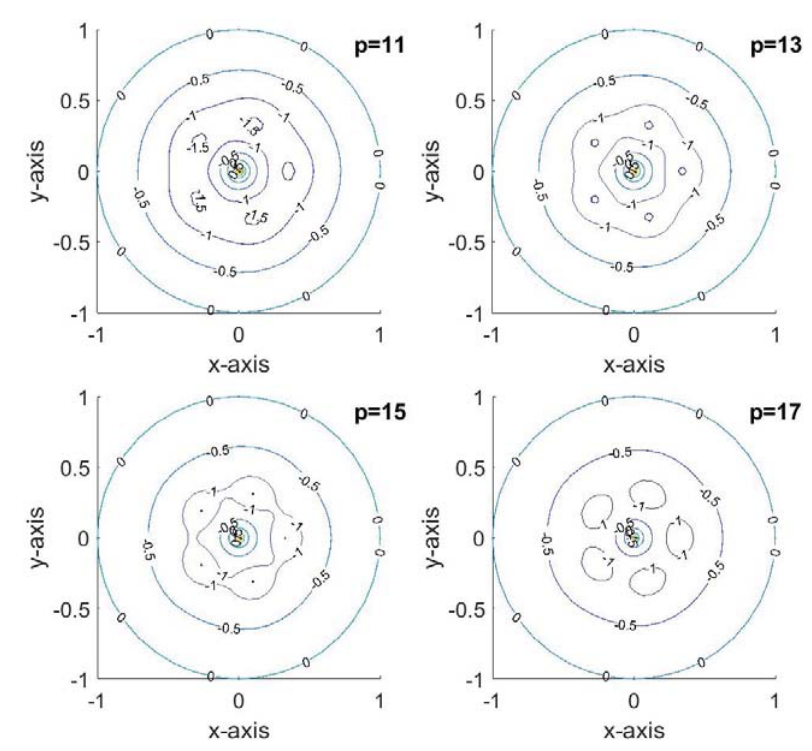
Fig. 16: Level sets of the numerical solutions with two nodal regions and 5-symmetry